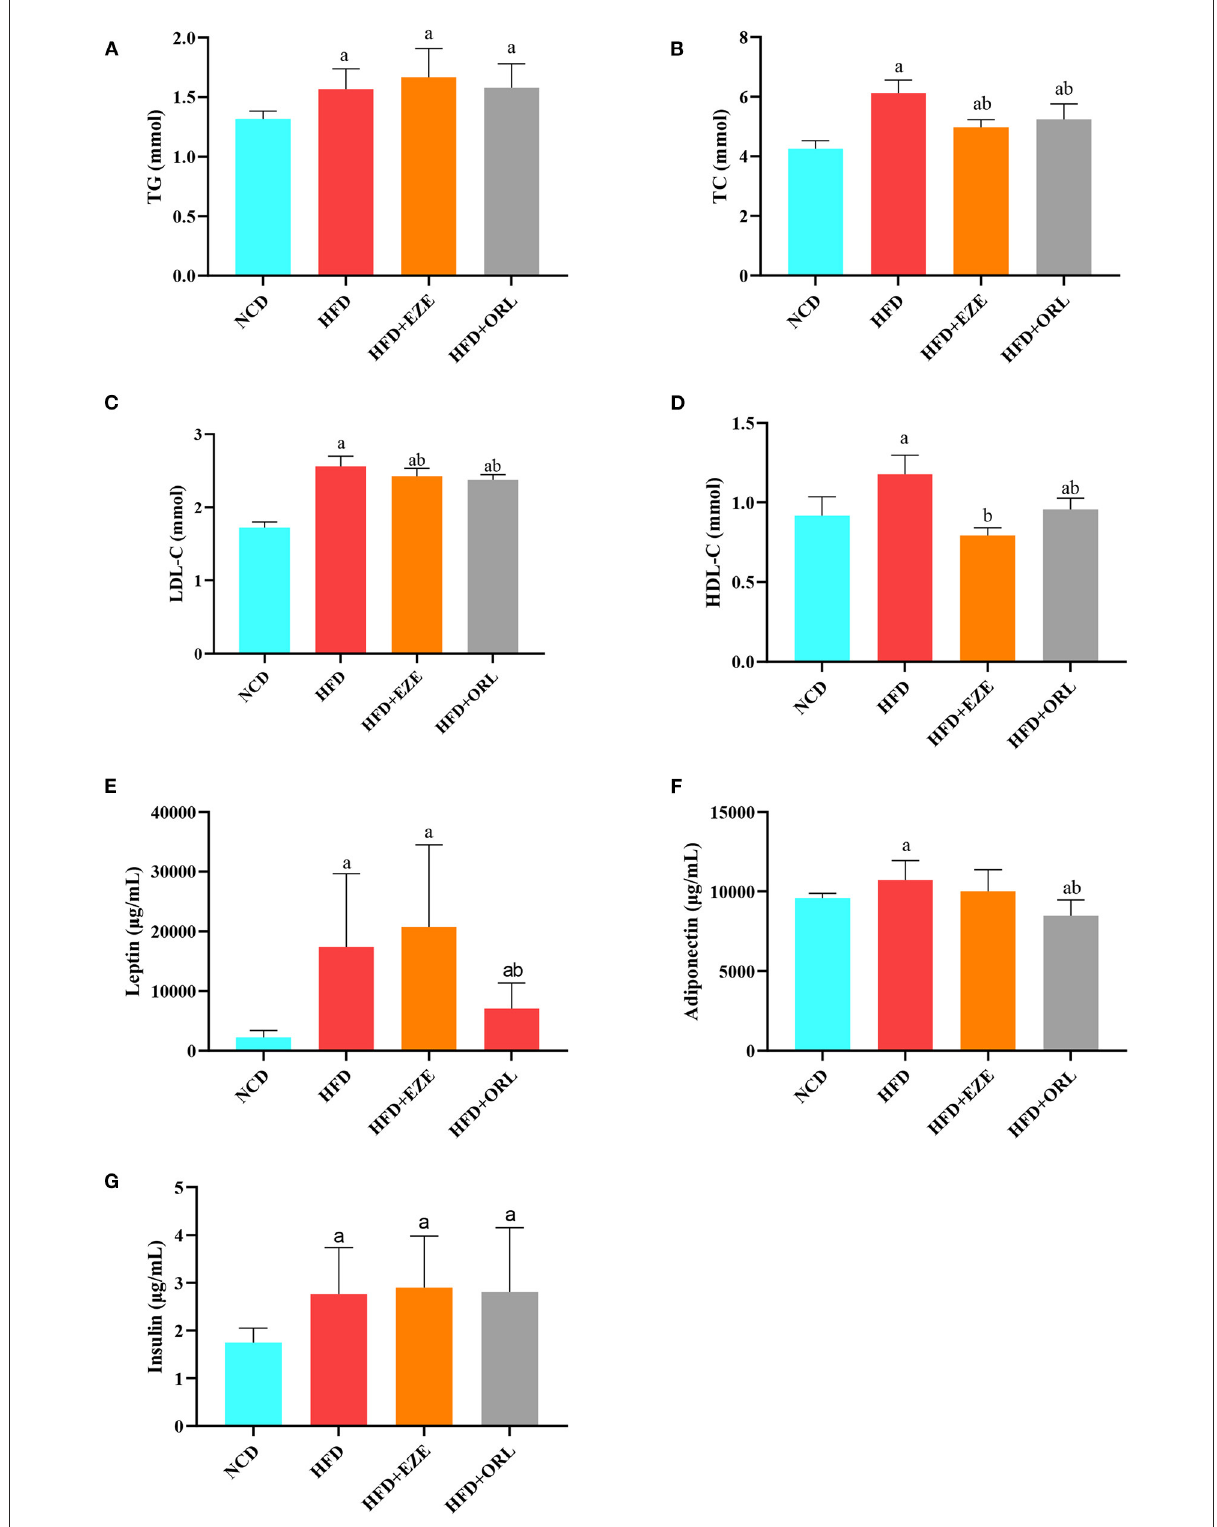
FIGURE2 Serum biochemical parameters of mice at week 20. (A) Triglyceride (TG) levels. (B) Total cholesterol (TC) levels. (C) Low-density lipoprotein-cholesterol (LDL-C) levels. (D) High-density lipoprotein-cholesterol (HDL-C) levels. (E) Leptin levels. (F) Adiponectin levels. (G) Insulin levels. a: P < 0.05 compared with the NCD group. b: P < 0.05 compared with the HFD group. NCD, normal diet; HFD, high-fat diet; HFD + EZE, high-fat diet and intervention of ezetimibe; HFD + ORL, high-fat diet and intervention of orlistat; n = 10 per